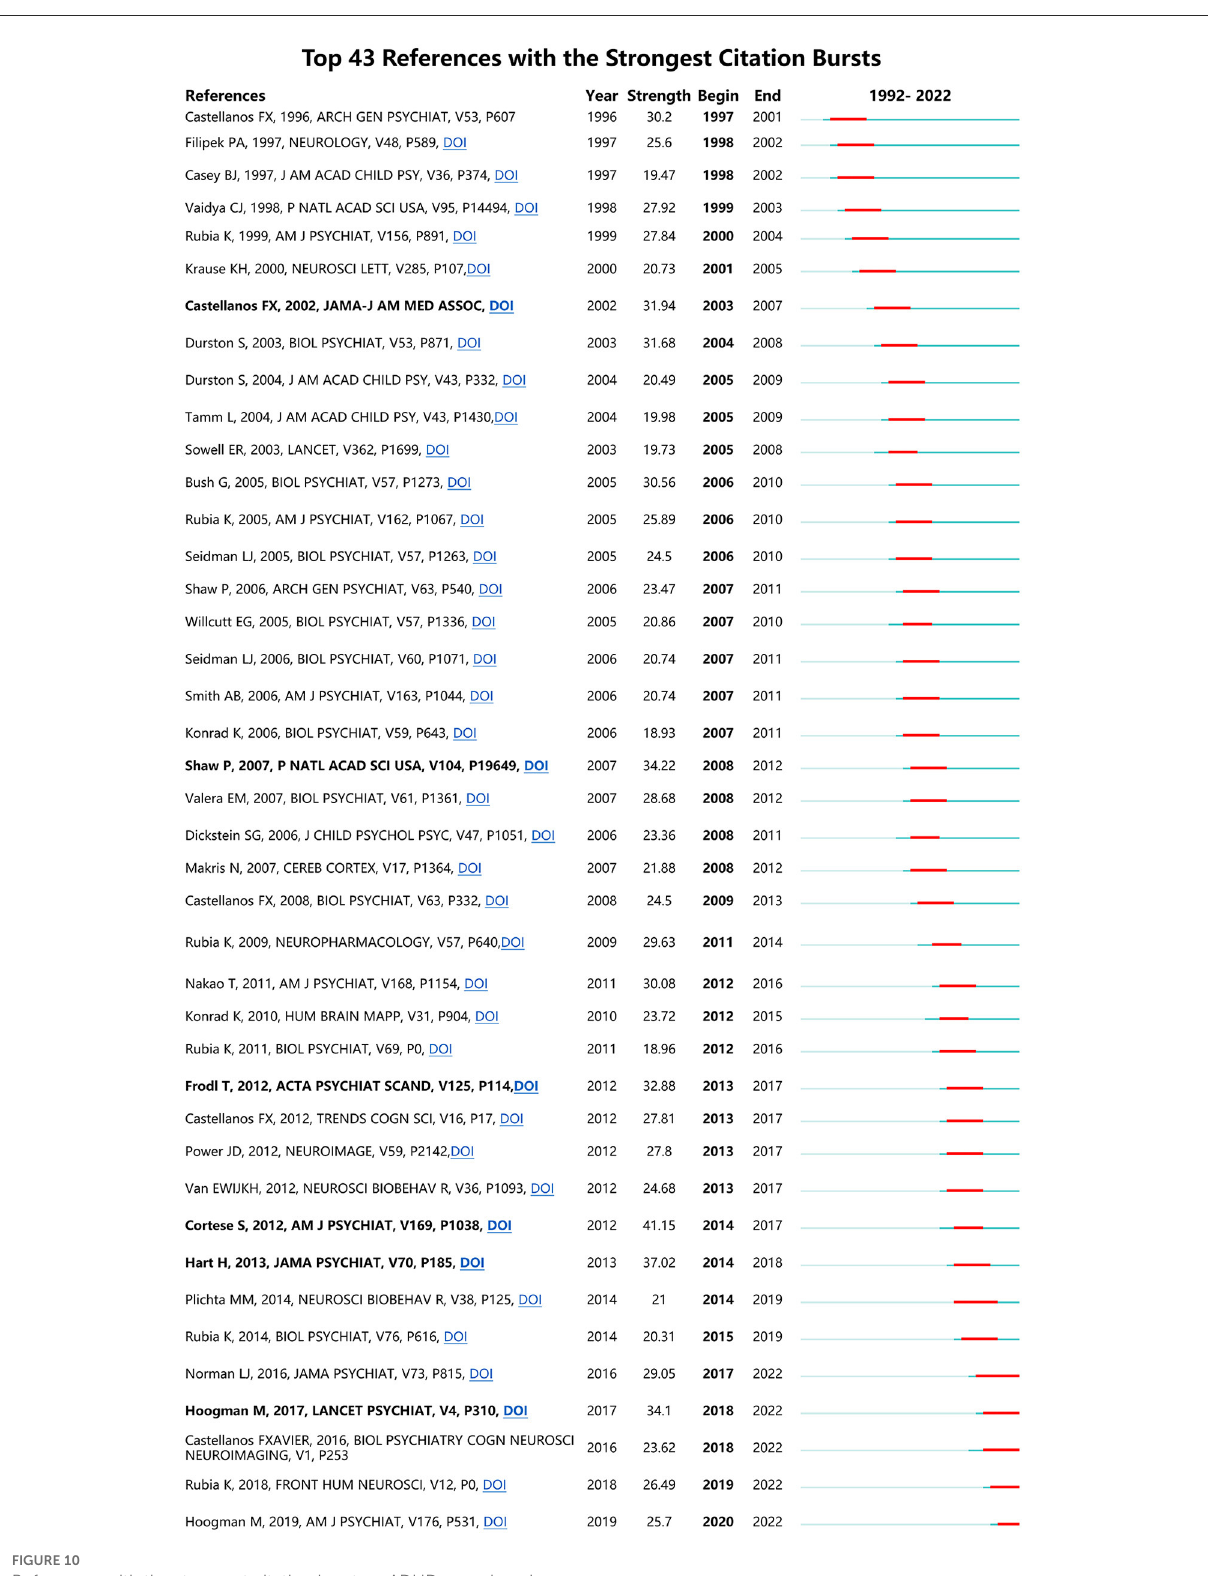
FIGURE10 References with the strongest citation burst on ADHD